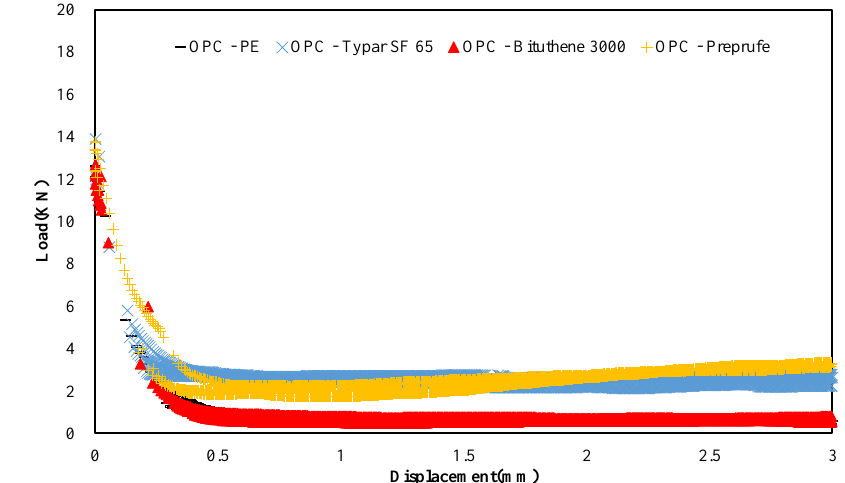
Figure 3. Load-displacement curve during crack propagation (OPC).